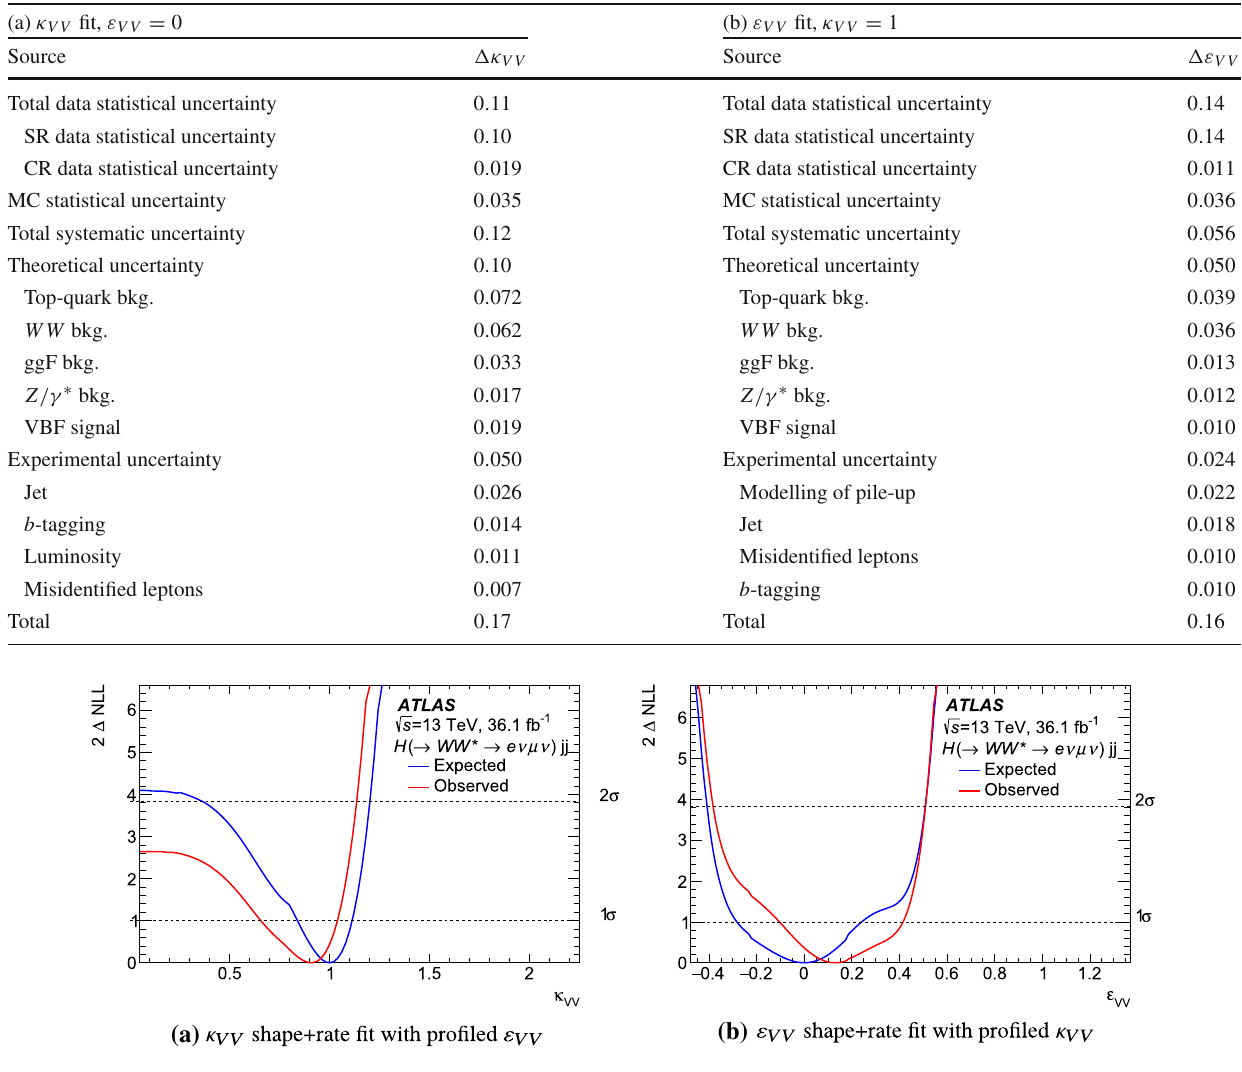
Fig. 9 Likelihood scans over a κ VV and b ε VV , with the other parameter profiled. The fits are performed using both shape and rate information. All relevant experimental and theoretical systematic uncertainties are considered in the